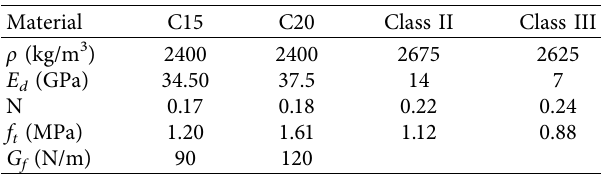
Figure 7: Finite element analysis model of gravity dam. Table 1: Material